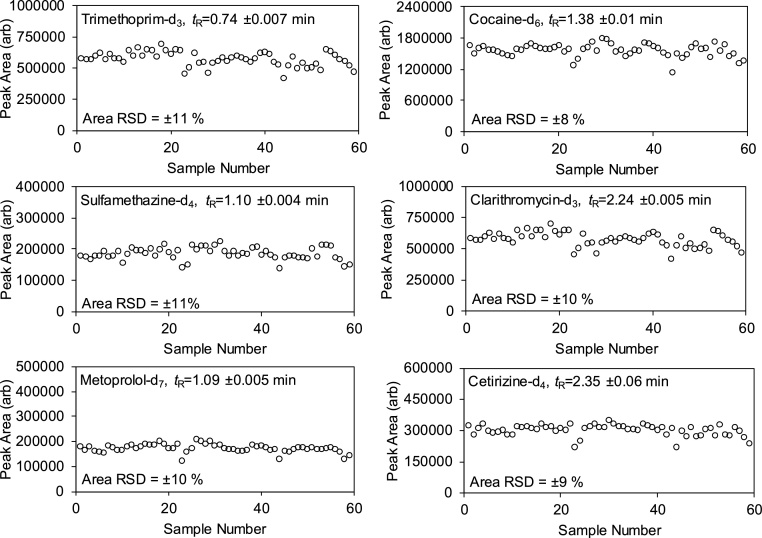
Peak area and retention time stability for selected SIL-IS over a sequence of n = 59 spiked London wastewater samples (500 ng L−1) and measured using direct LC–MS/MS analysis over a total batch analysis time of 6.4 h.